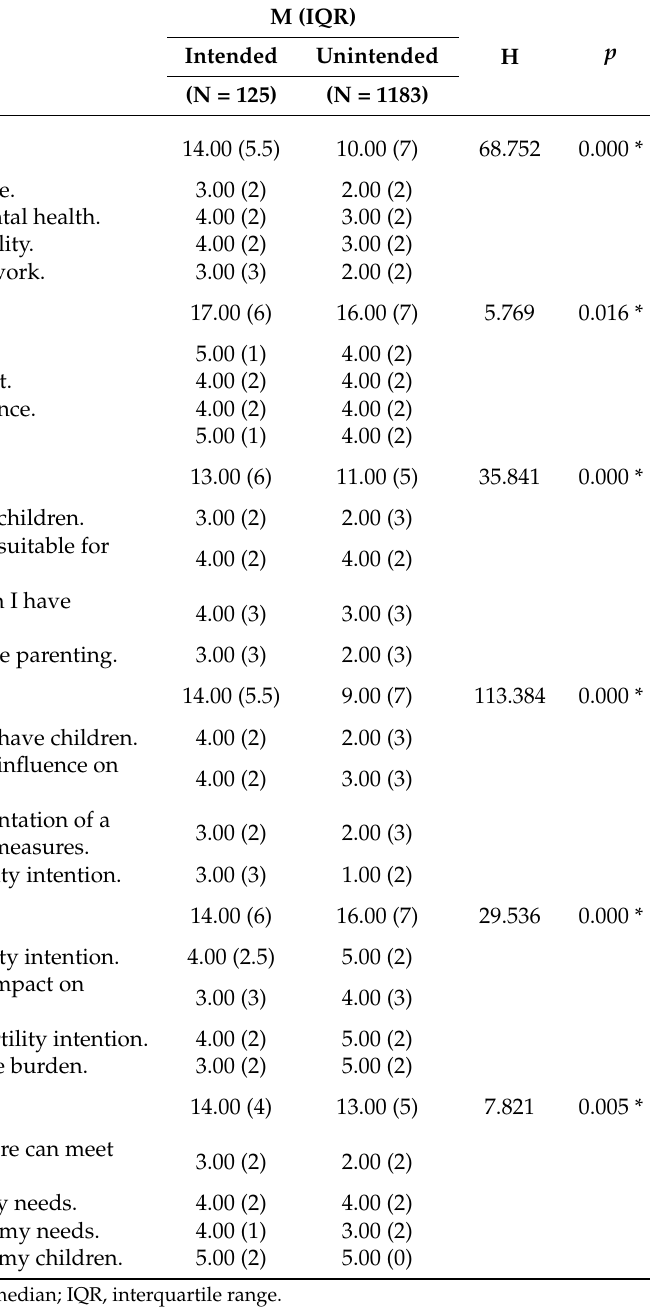
Table 3. Scores of determinants of fertility intentions scale (N =